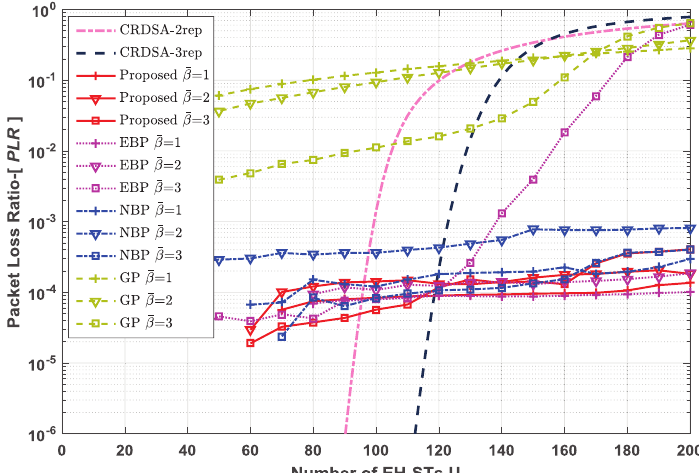
Figure 6. Comparison of packet loss ratio of different policies for different network sizes, under different EH rates ¯ β ∈ { 1,2,3 } , e max = 10. For RA schemes, number of time slots in each frame N = 200, QPSK modulation, E s / N 0 = 10